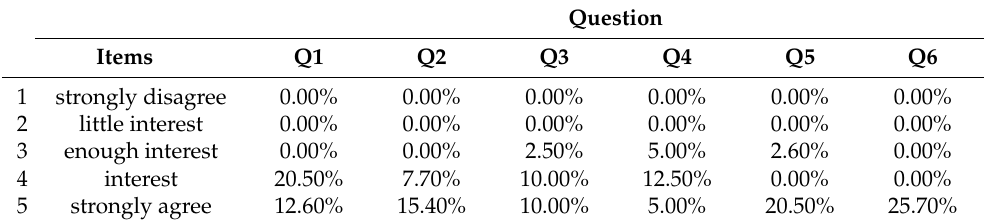
Table 7. The satisfaction level response proportion of girls >= 12 years old (secondary education).